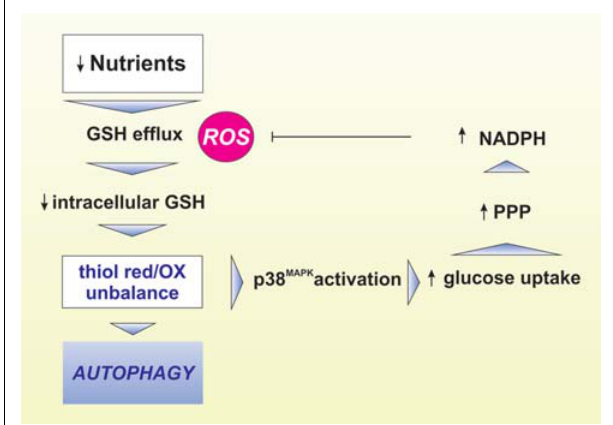
FIGURE 2 | Role of GSH in the modulation ofATG. Lack of nutrients leads to increased reactive oxygen species (ROS) production concomitant to intracellular GSH efflux through the cell membrane.These events result in thiol redox unbalance leading to activation of crucial proteins involved in ATG induction and execution. Under nutrient restriction, the phoshorylative signaling cascade governed by p38 MAPK favors glucose uptake leading to the increase of NADPH production via the enhancement of pentose phosphate pathway (PPP). NADPH in turn contributes to buffer higher ROS-mediated oxidative